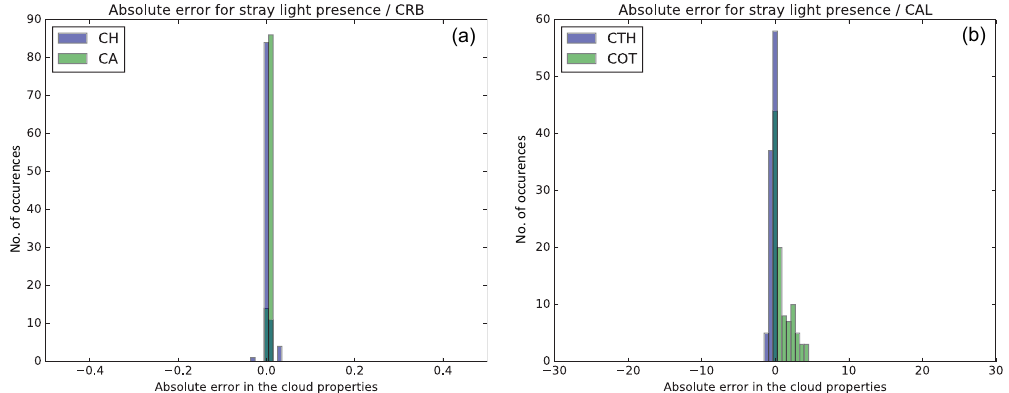
Figure 7. Absolute errors in the cloud properties due to the presence of stray light: (a) cloud height and cloud albedo errors for CRB and (b) cloud top height and cloud optical thickness errors for CAL.